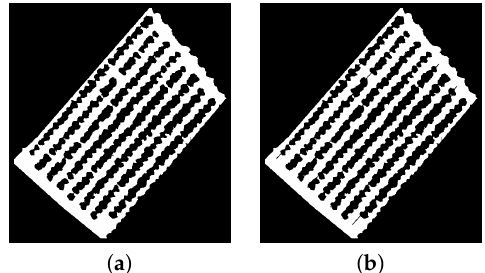
Figure 10. Generating Speed images: ( a ) the original Path binary map and ( b ) the modified map.